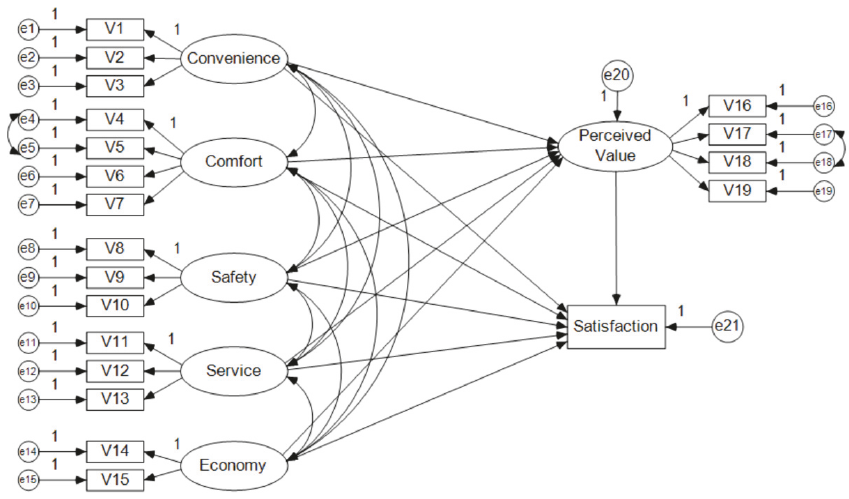
Figure 2: Theoretical model